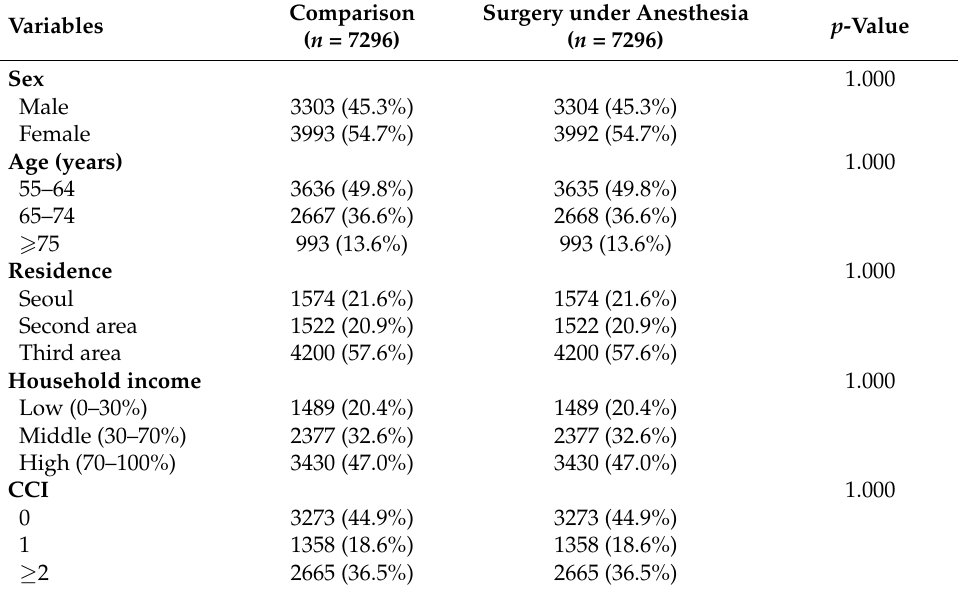
Table 1. Characteristics of the